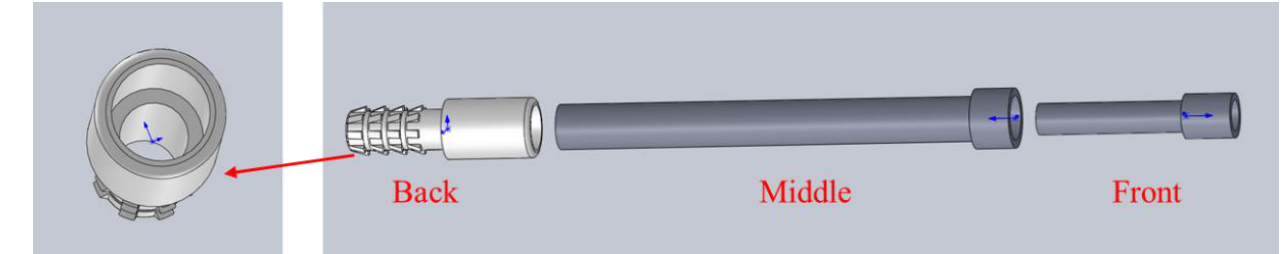
Figure 2. Structure of the foam penetration-filter tube.